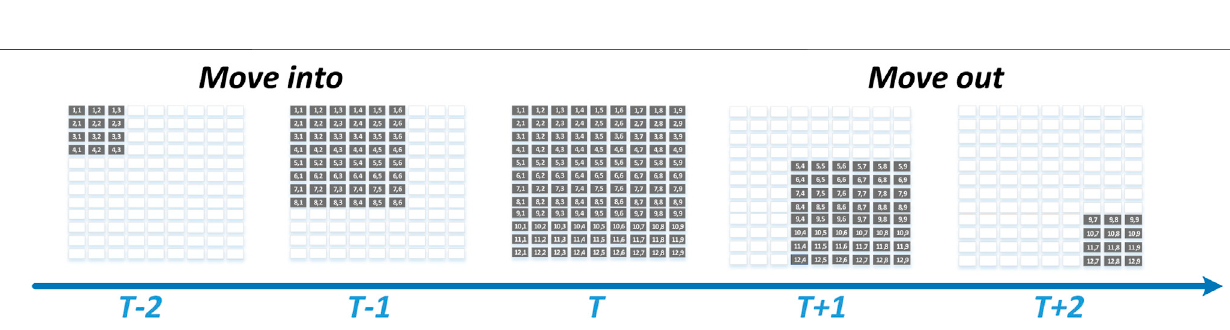
FIGURE 6 | Hourly data for the ideal solar radiation S s ( t ) received by the PV panel and the declination angle of the Sun δ during a year.